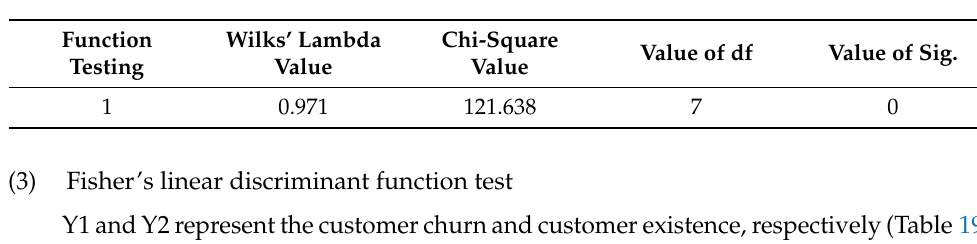
Table 18. Wilks’ lambda values.